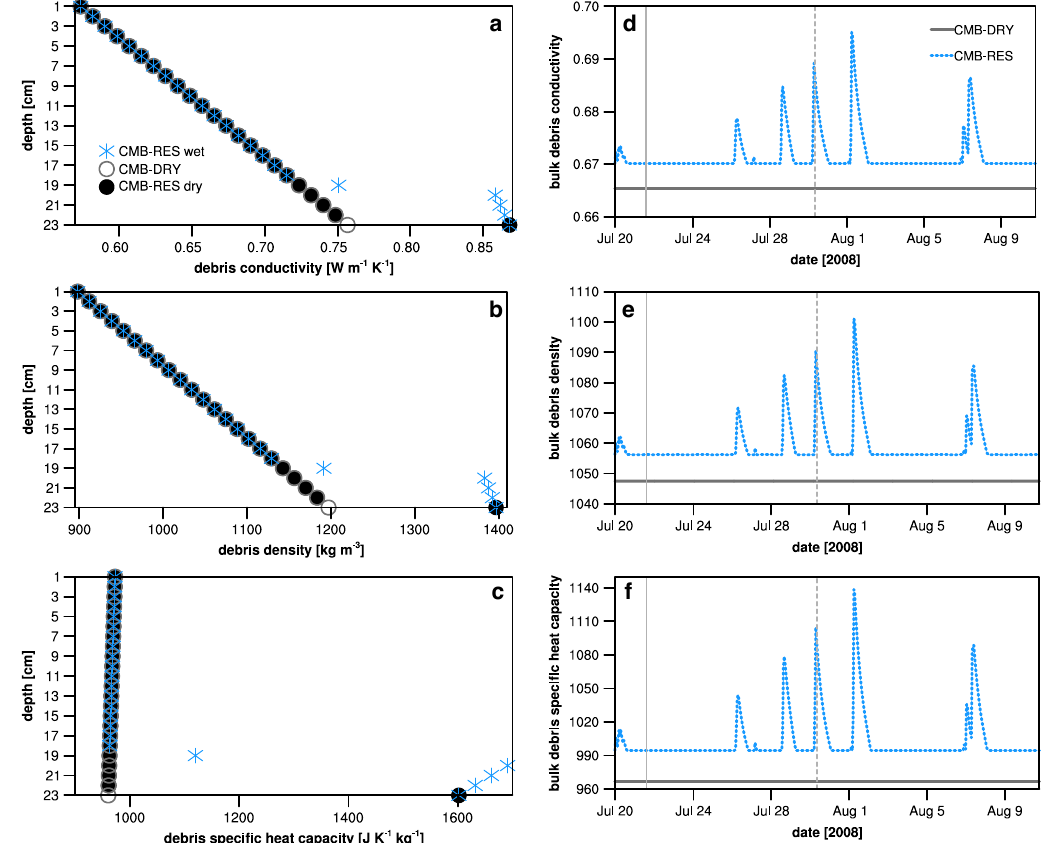
Figure 8. Depth variation of (a) debris thermal conductivity (Wm − 1 K − 1 ), (b) density (kgm − 3 ), and (c) specific heat capacity (Jkg − 1 K − 1 ), shown for CMB-DRY in grey-unfilled circles and for CMB-RES in both black-filled circles (“dry” time slice) and blue asterisks (“wet” time slice). Time series of bulk values for these same properties are shown in panels (d–f) for CMB-RES in blue and CMB-DRY in grey. The locations of the “dry” and “wet” time slices are indicated by the first (solid grey) and second (dashed grey) reference lines on the x axis, respectively.